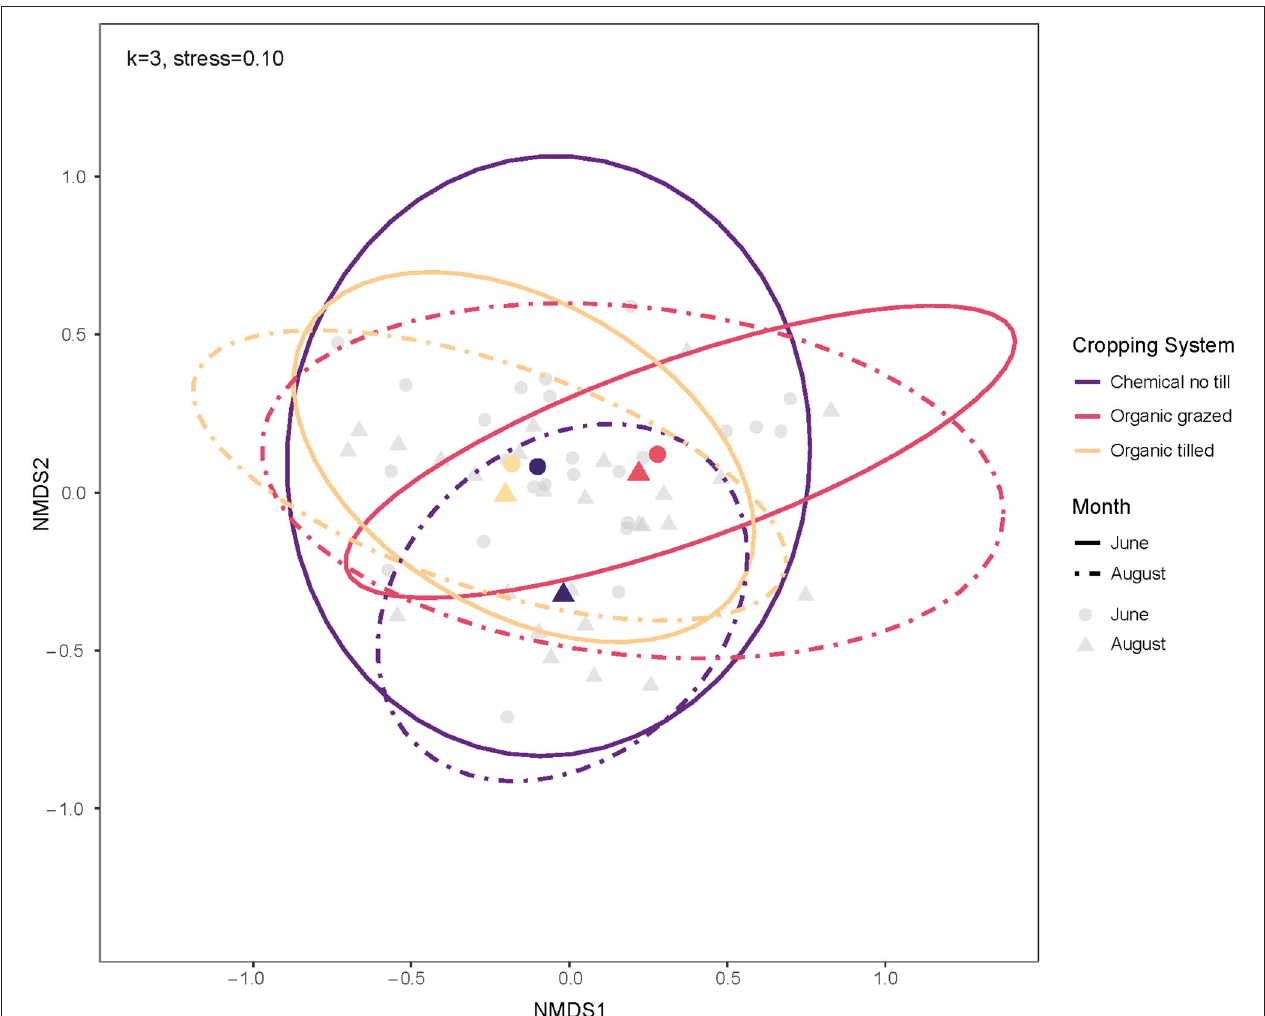
FIGURE 4 | Ordination of soil bacterial communities by cropping system for June and August using non-metric multidimensional scaling on weighted Bray-Curtis dissimilarities. The centroids and multivariate t-distribution ellipses for bacterial communities in the three cropping systems are designated by color for both June (circles, solid line) and August (triangles, dashed line). For the NMDS calculation, k = 3, and stress =